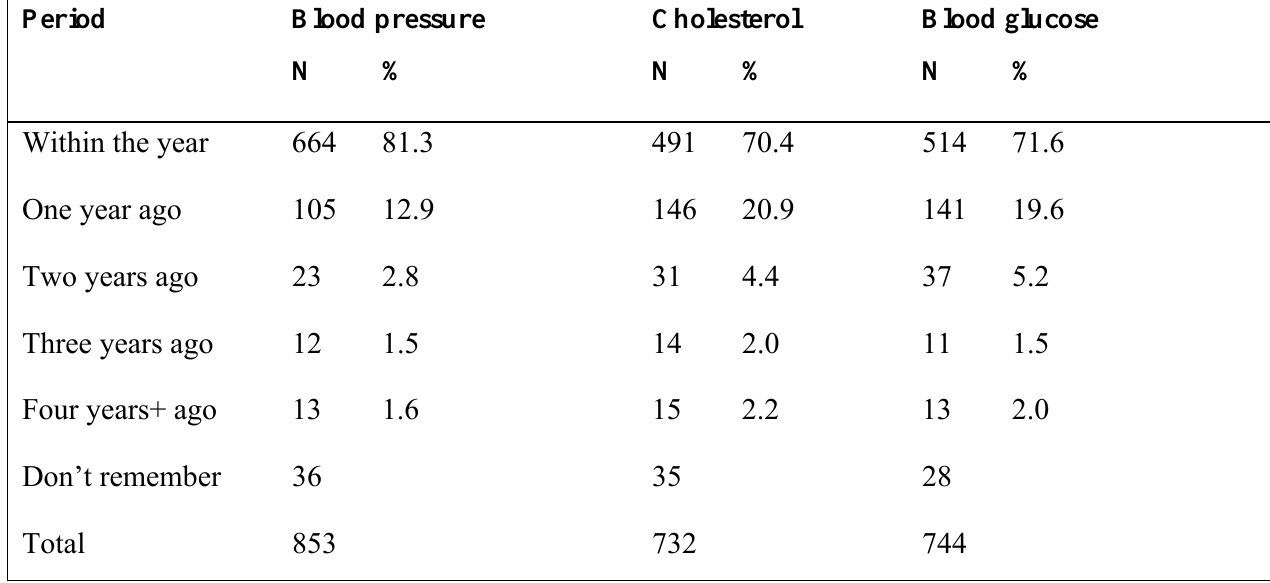
Table 1. Time distribution of the last preventive